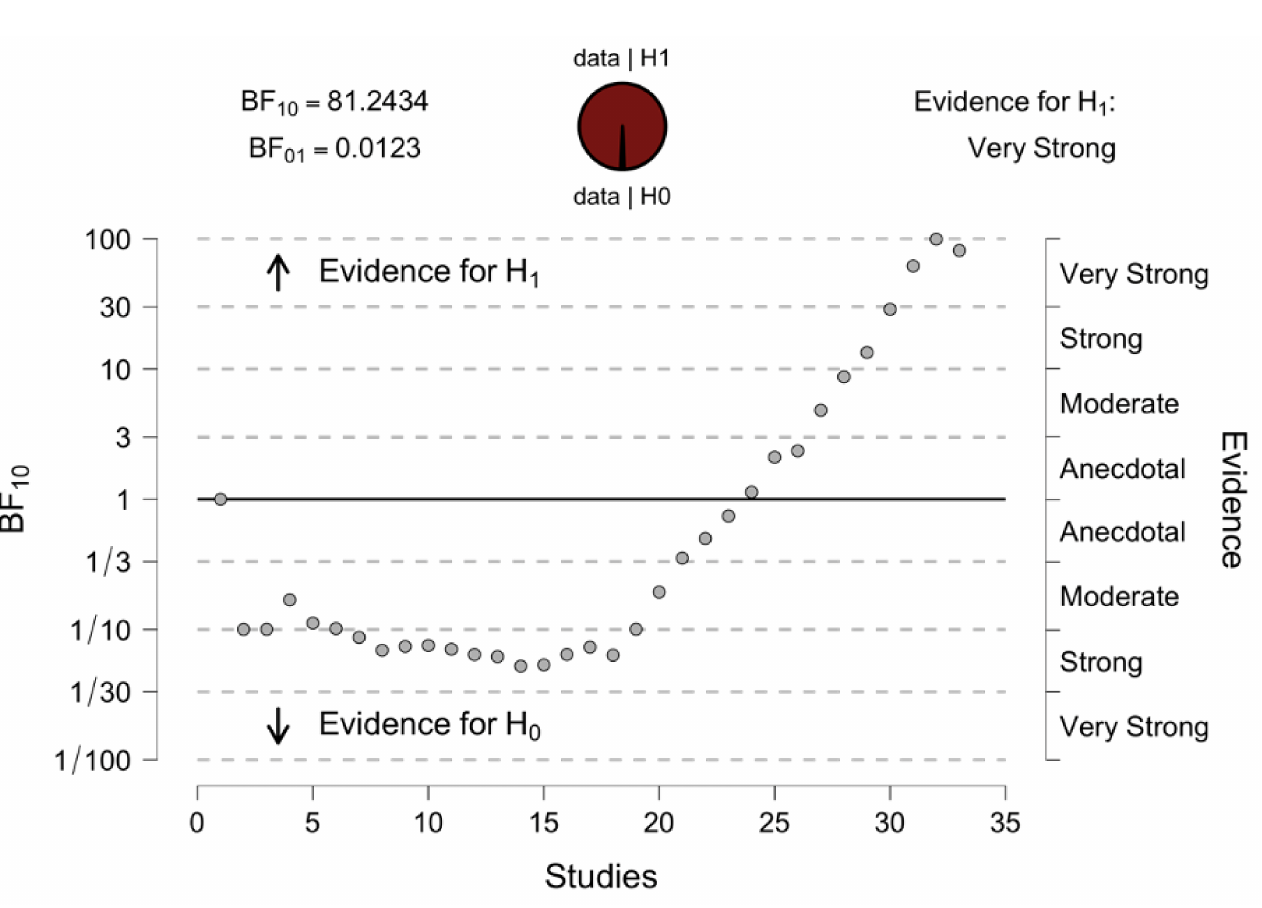
Figure 4. Sequential analysis of effects and Bayes factors for H1 against